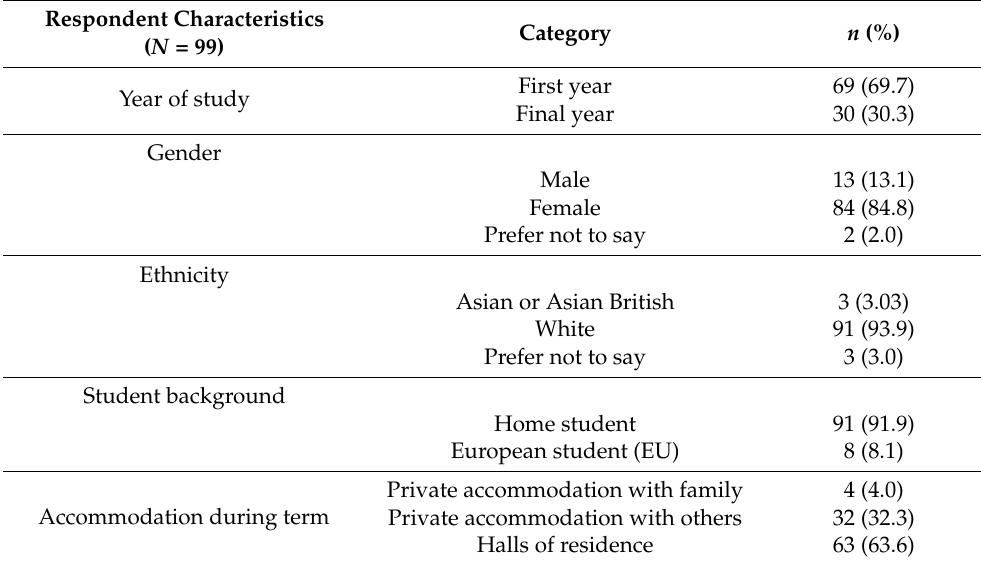
Table 2. Sample characteristics of survey respondents ( n =